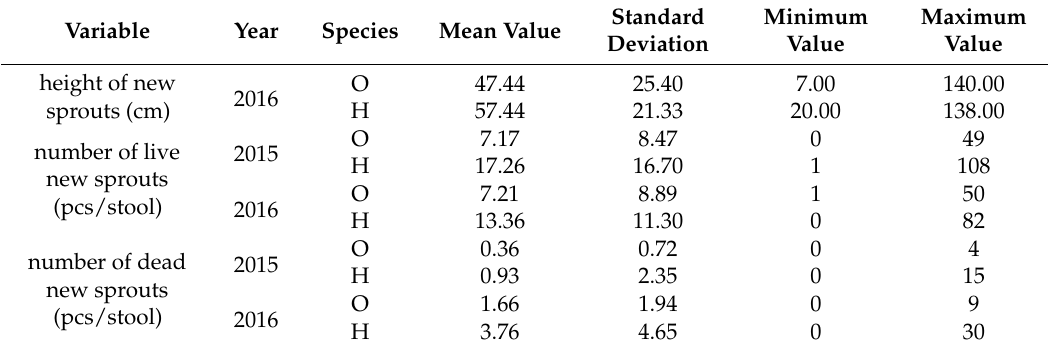
Table 2. Basic parameters of new